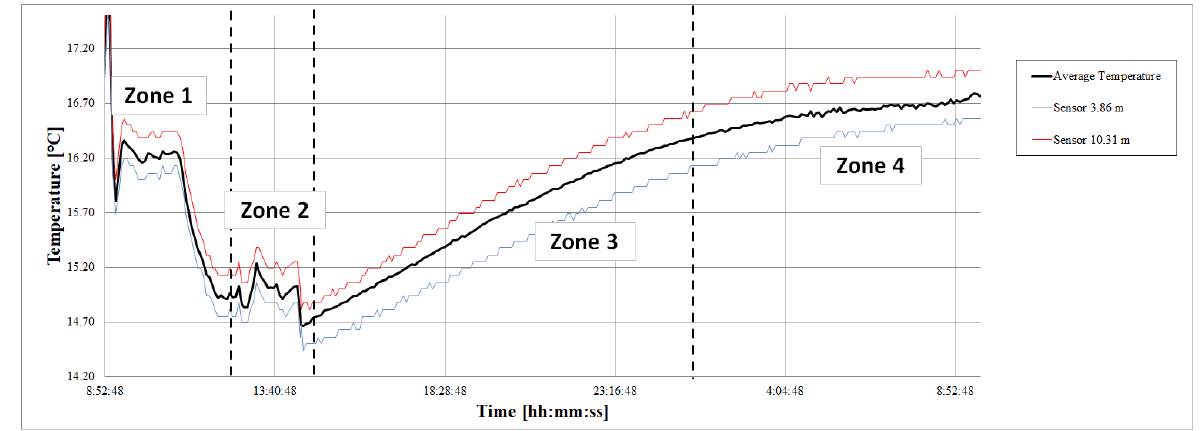
Figure 20. Temperature measured by S3.86 and S10.31 sensors, characterized by maintaining the